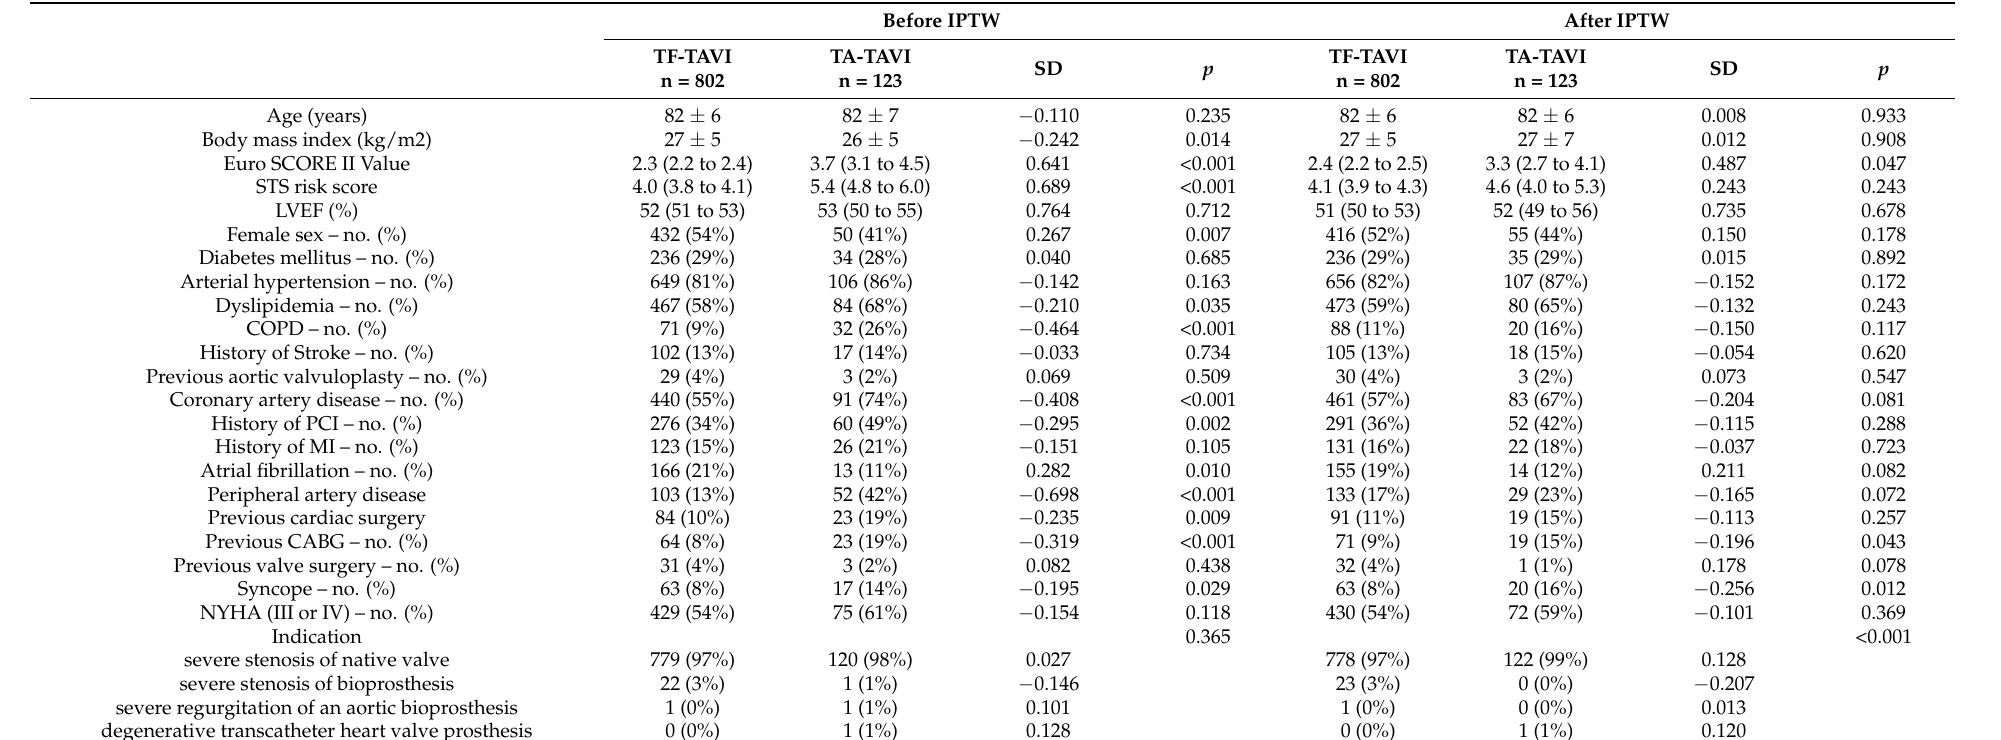
Table 1. Baseline characteristics before and after